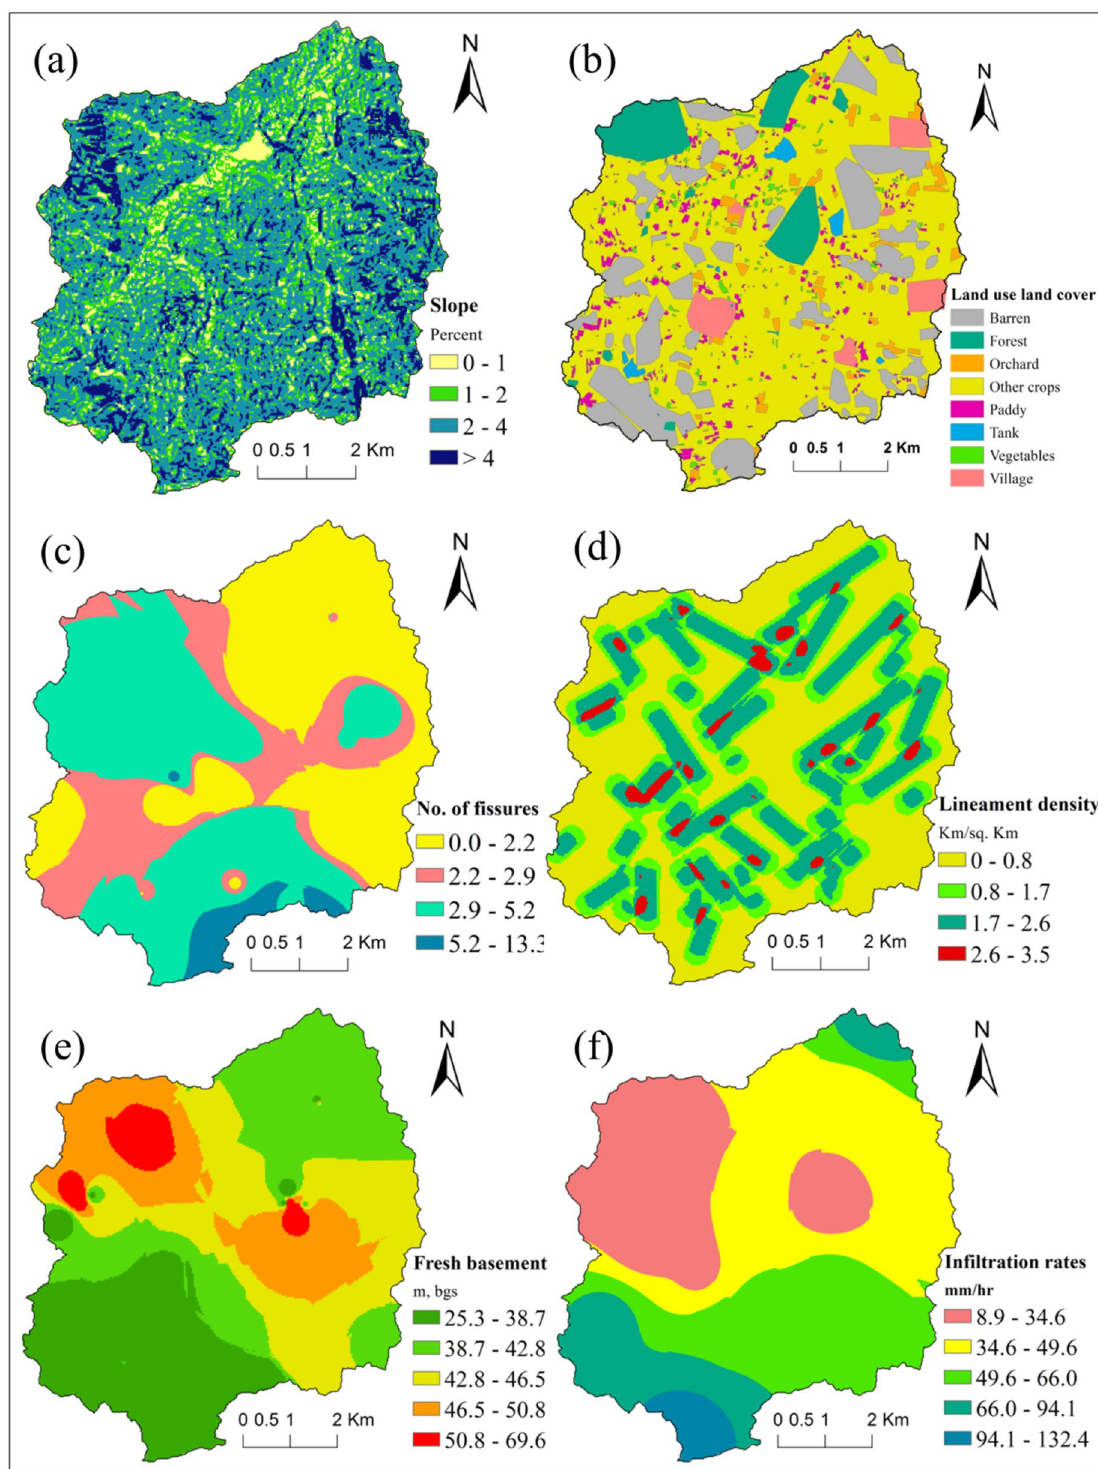
Figure 3. Map showing input thematic layers ( a ) slope, ( b ) Lulc, ( c ) fissures, ( d ) lineament density, ( e ) depth to basement and ( f ) infiltration rates of Maheshwaram watershed, India. Desktop. 10.3. ESRI, California, US. https:// deskt op. arcgis.